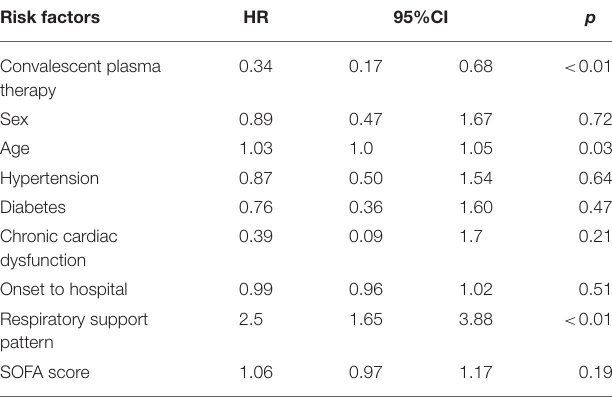
TABLE 4 | Effects of convalescent plasma therapy on 60-day mortality according to subgroups in severe and life-threatening coronavirus disease 2019 (COVID-19). Subgroup Adjusted